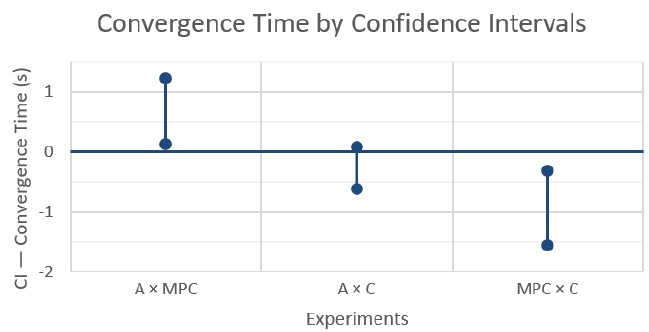
Figure 3. Differences in convergence time between the rendezvous techniques with 99% confidence